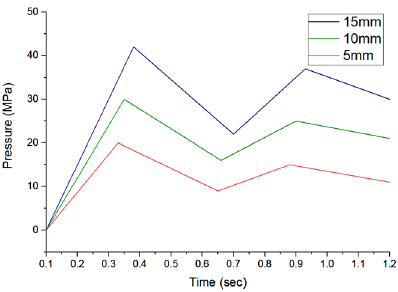
Figure 16. Maximum stress of the di ff erent raised universal joints.